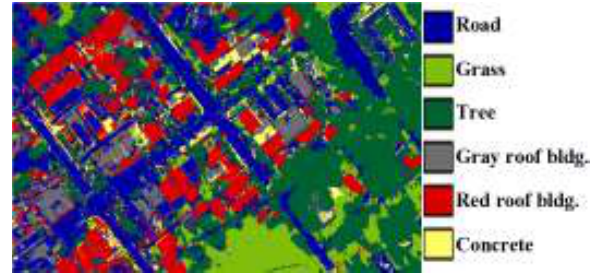
Figure 2. Results obtained for the RGB image